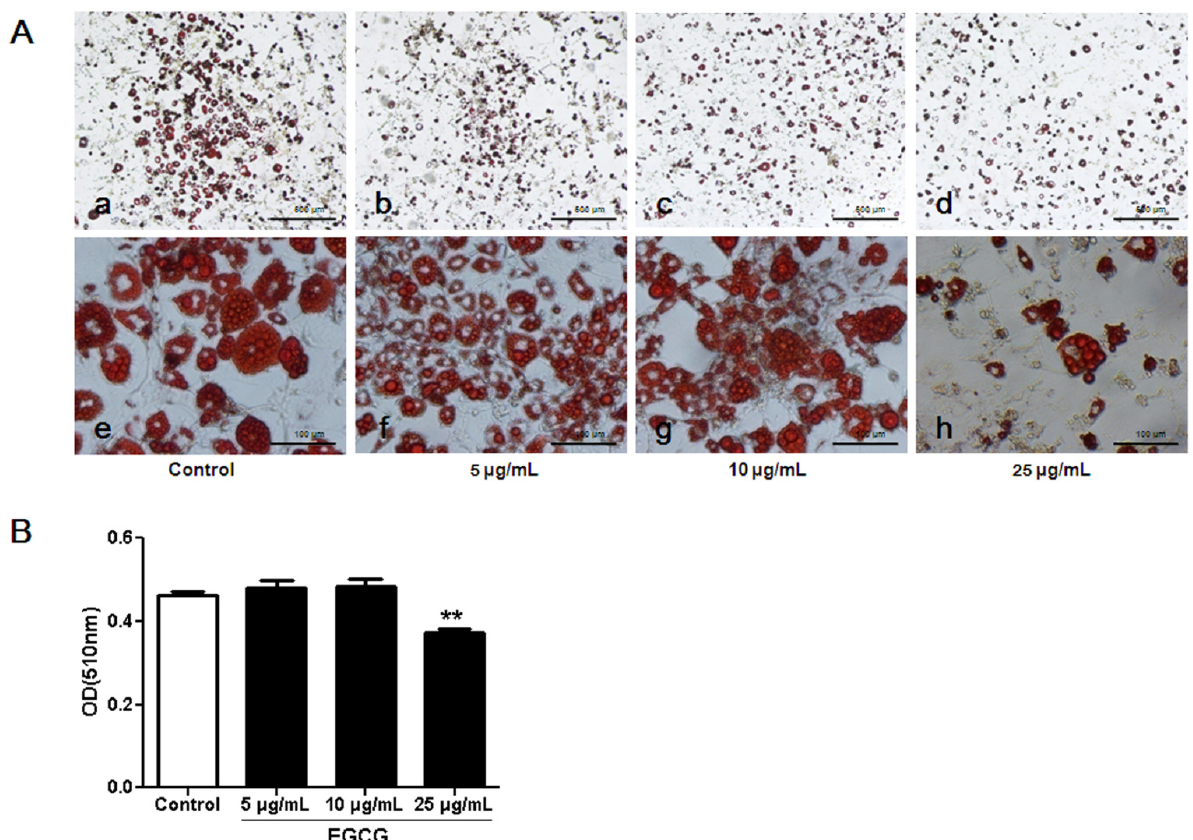
Figure 2. The effects of ( − ) ‐ Epigallocatechin ‐ 3 ‐ gallate (EGCG) on the inhibition of fat accumulation in 3T3 ‐ L1 adipocytes. ( A ) The 3T3 ‐ L1 adipocytes were treated with different concentrations of EGCG and lipid droplets were stained with Oil red O stain. The cells were photographed at magnification ×40 ( a – d ) and ×200 ( e – h ). The experiment was performed three times in triplicate for each concentration. Representative images are shown; ( B ) The oil red O stained cells were treated with isopropanol to extract the dye, and the concentration of the eluted dye was determined by absorbance at optical density(OD) 510 nm. Error bars represent standard deviation of the mean, n = 3. ** p < 0.01 vs. the control.